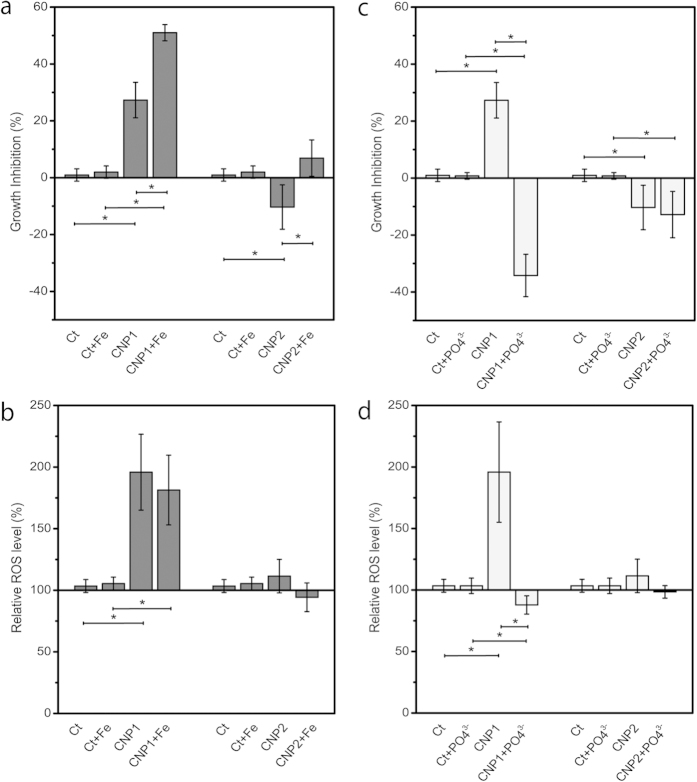
Effect of combined treatments of CNP1 and CNP2 with Fe (left column) or PO43– (right column) on the growth of P. subcapitata during 72 h (a,c), and intracellular ROS production (b,d).Mean ± standard deviation. Statistically significant differences (p < 0.05) are marked by asterisks.